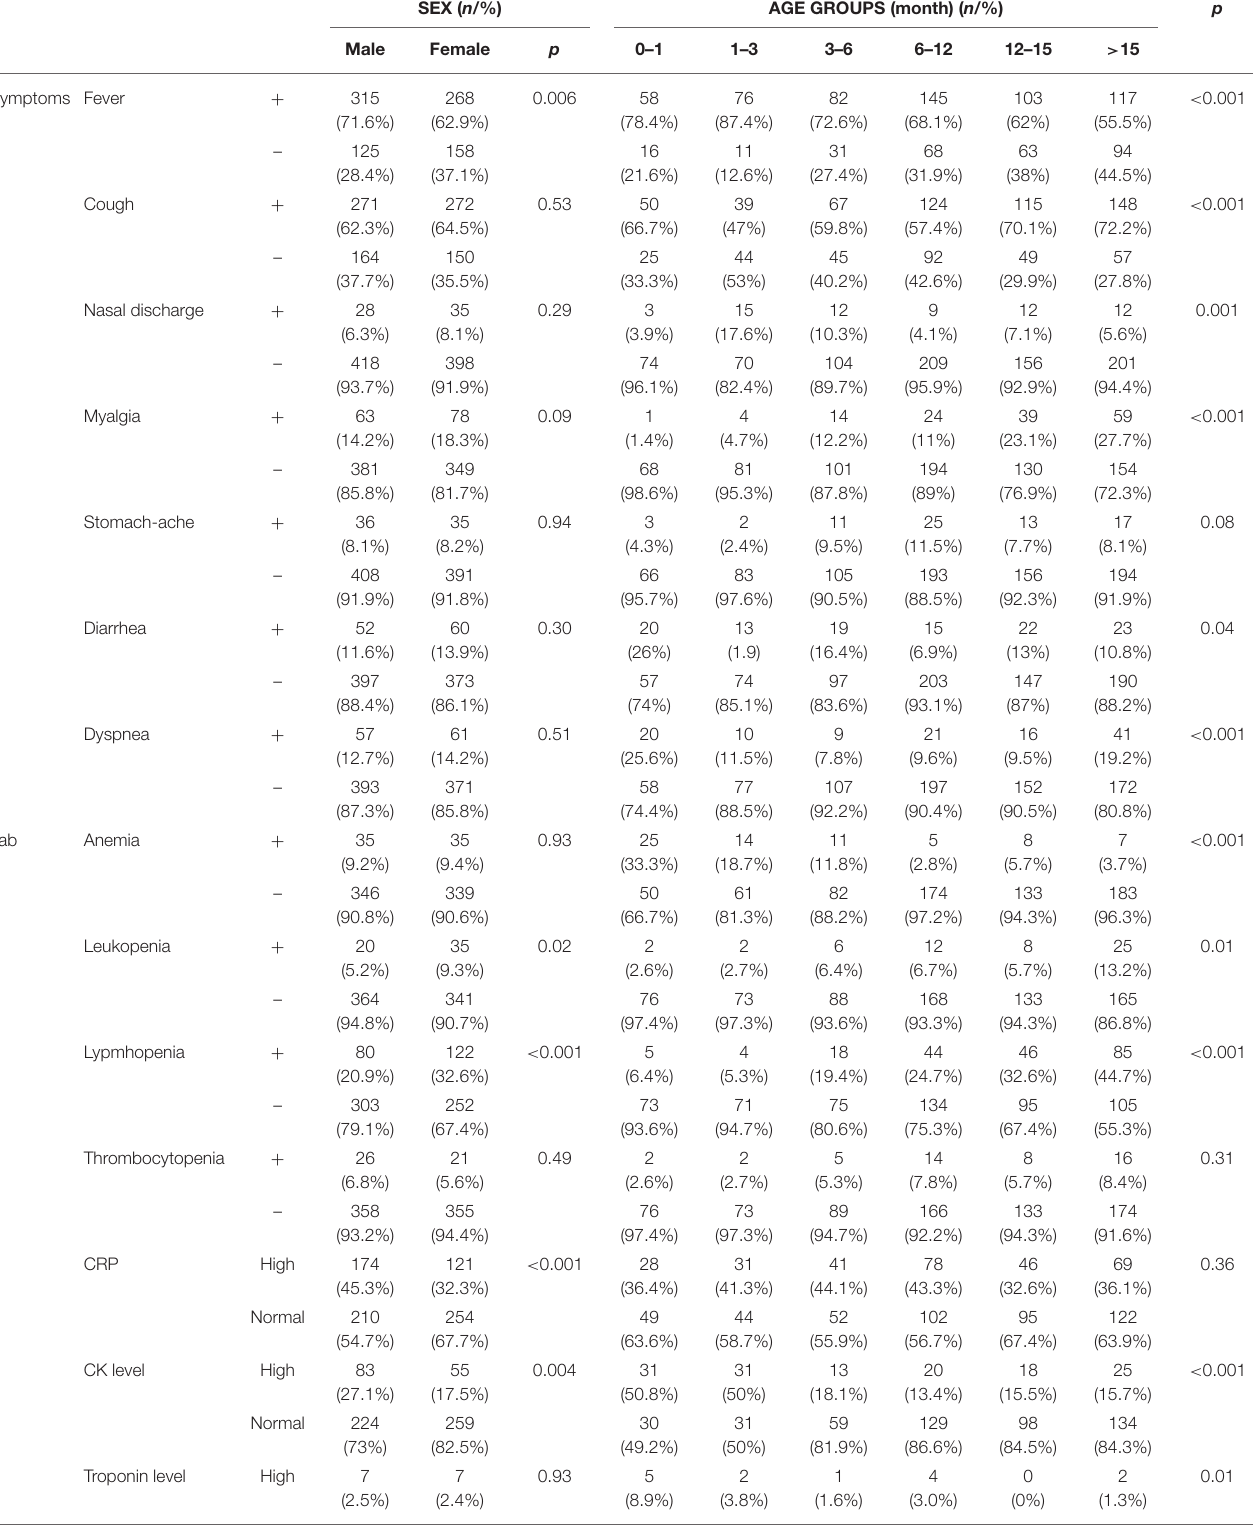
TABLE 4 | Comparison of symptoms and laboratory parameters by means of sex and age groups among symptomatic